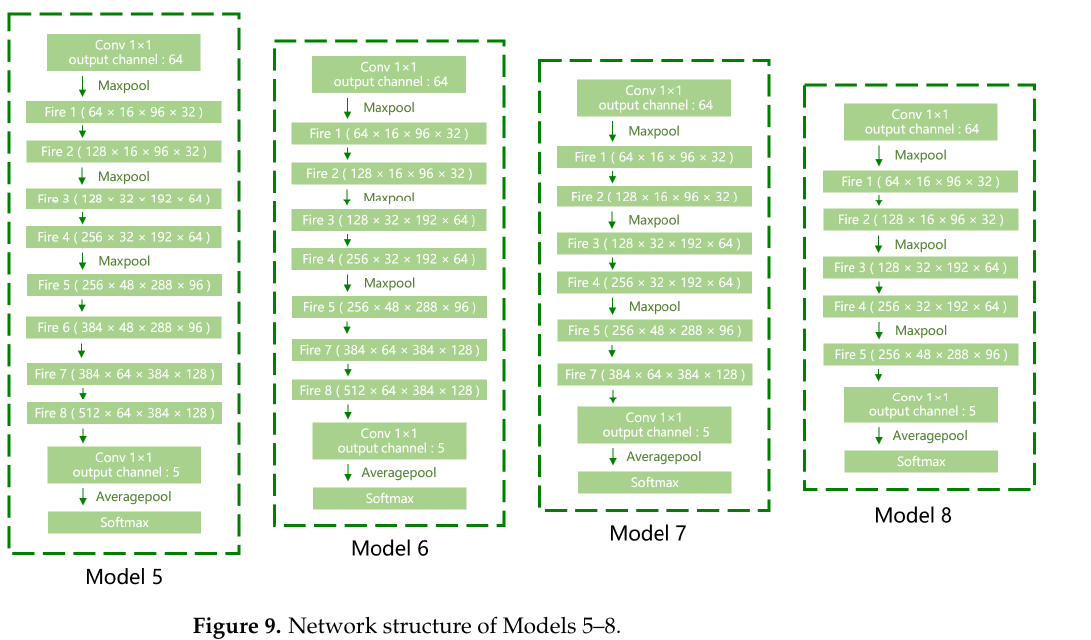
Figure 9. Network structure of Models 5–8.